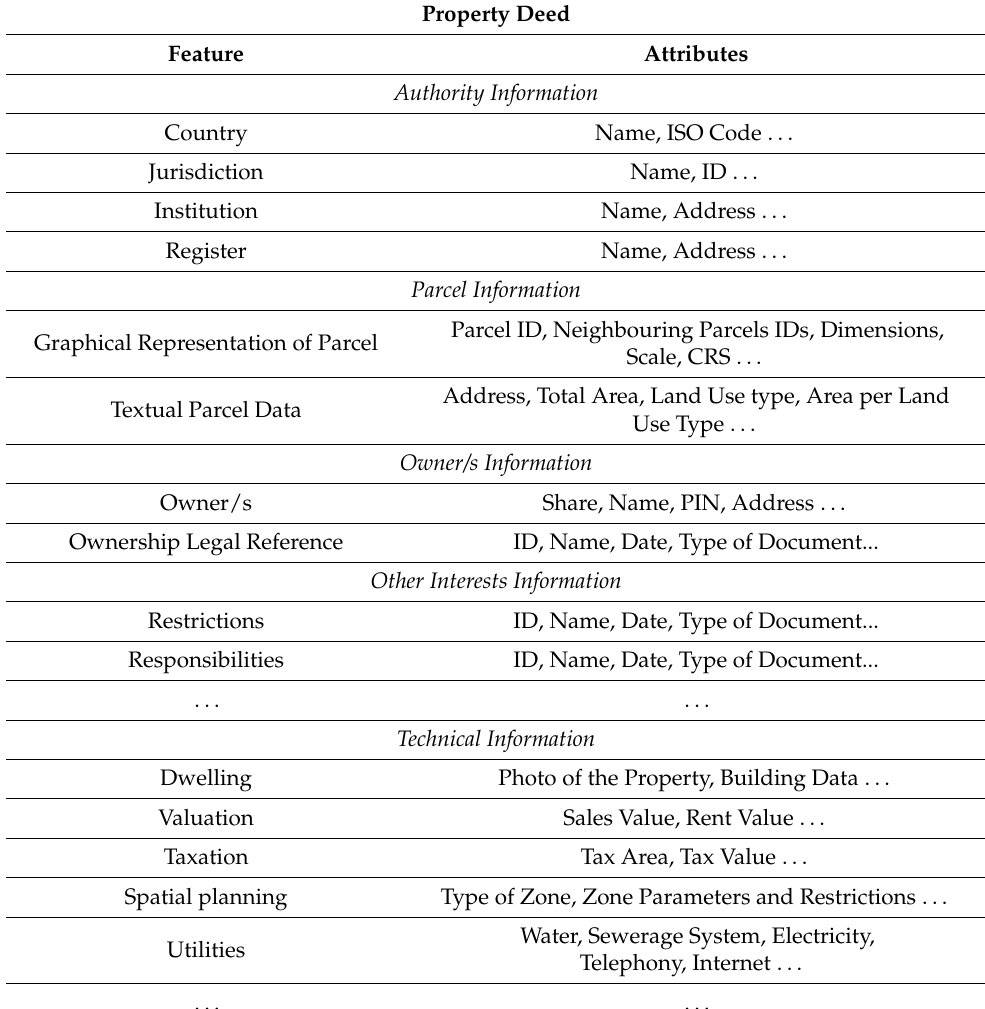
Table 5. Example of Property